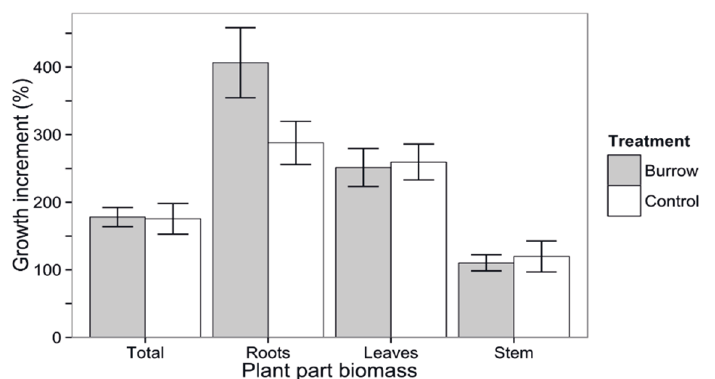
Figure 5. Mean increment in biomass (%, n = 9 for each treatment) of all plant parts (total) and each single plant part (roots, leaves and stem) between the first sampling (21 February 2013) and the last sampling (21 August 2013). Error bars represent the standard error